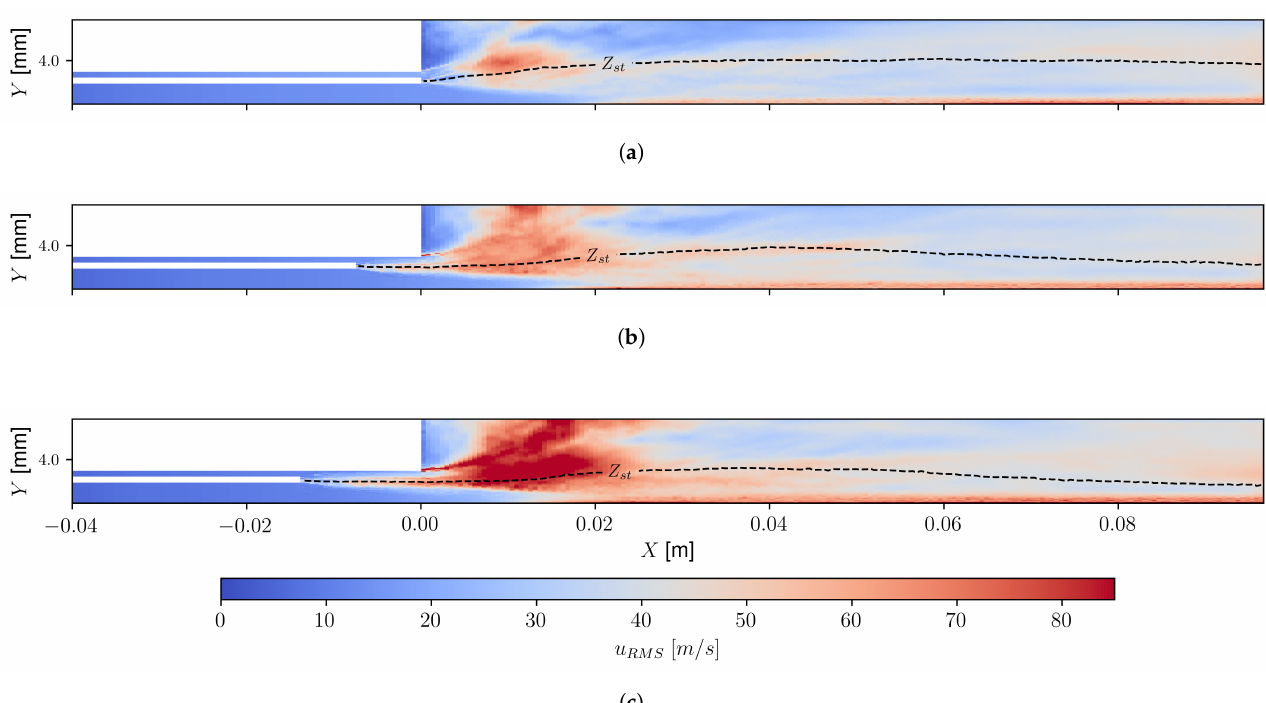
Figure 12. Ground truth LES u RMS field interpolated into a 256 × 128 Cartesian grid. ( a ) DP-A, ( b ) DP-B, and ( c ) DP-C. The stoichiometric line, denoted by Z st , has been overlaid on top. The aspect ratio of the figures has been modified purposely to facilitate their scrutiny.